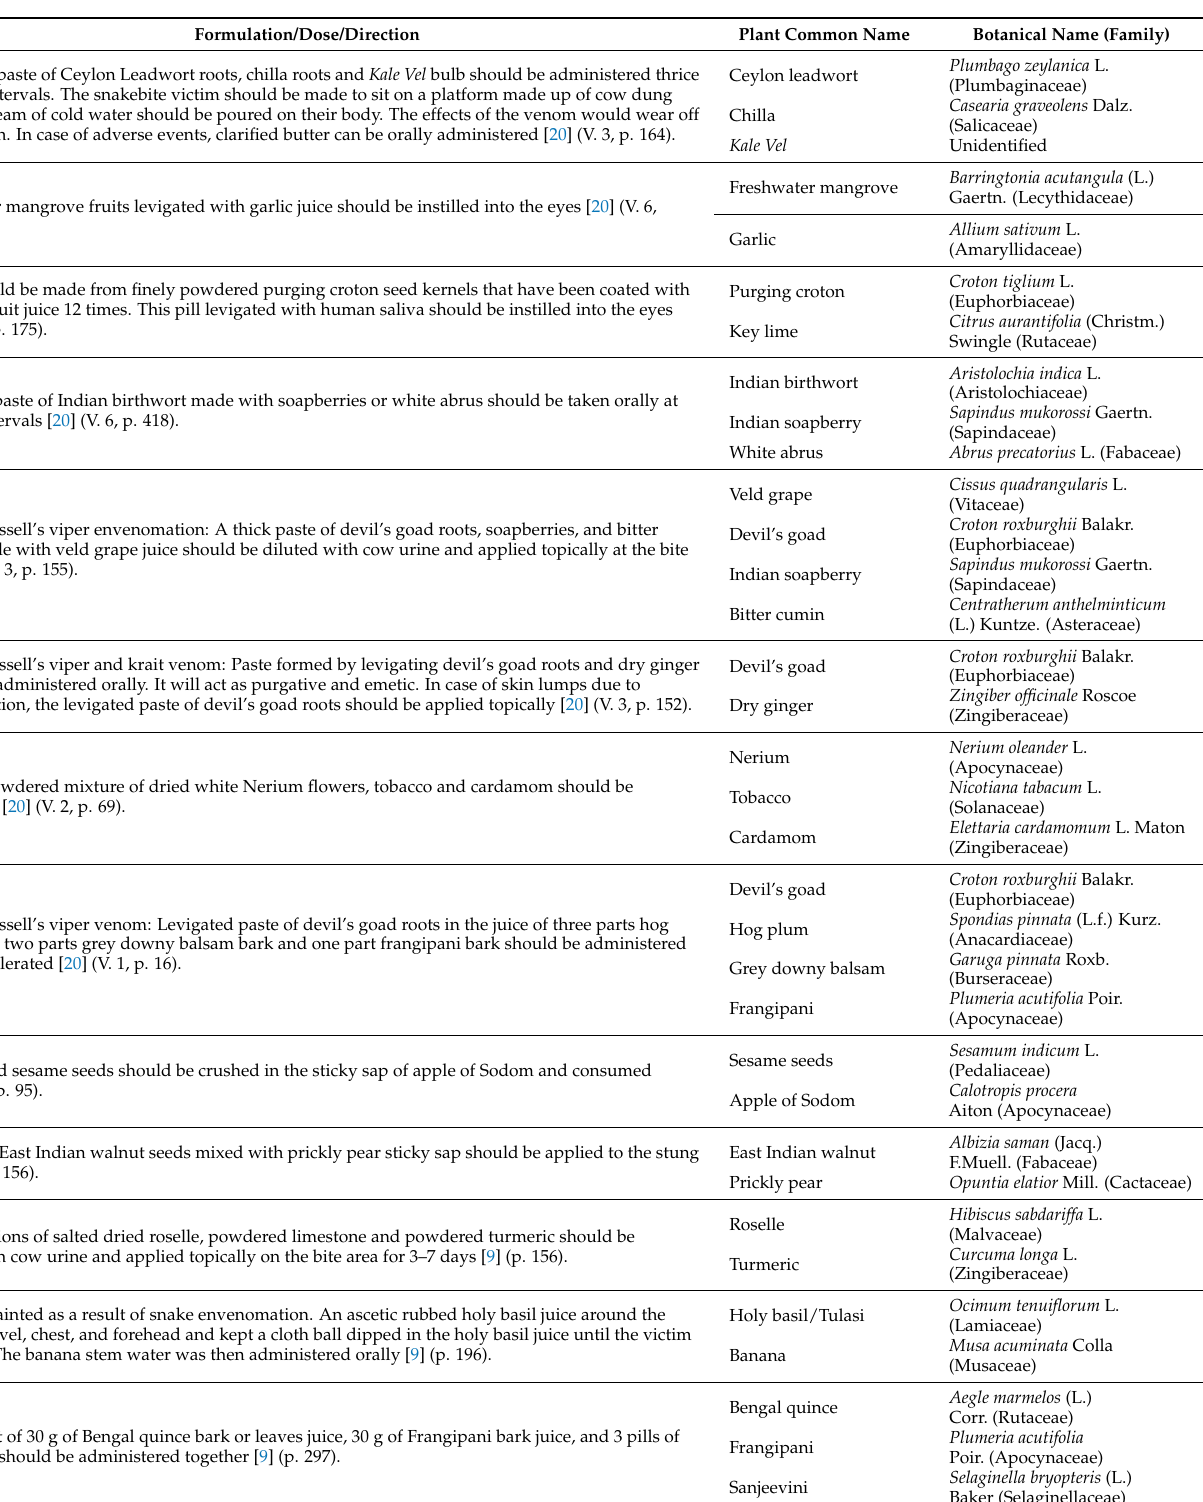
Table 2. Snake-bite therapies comprising 2–4 plant